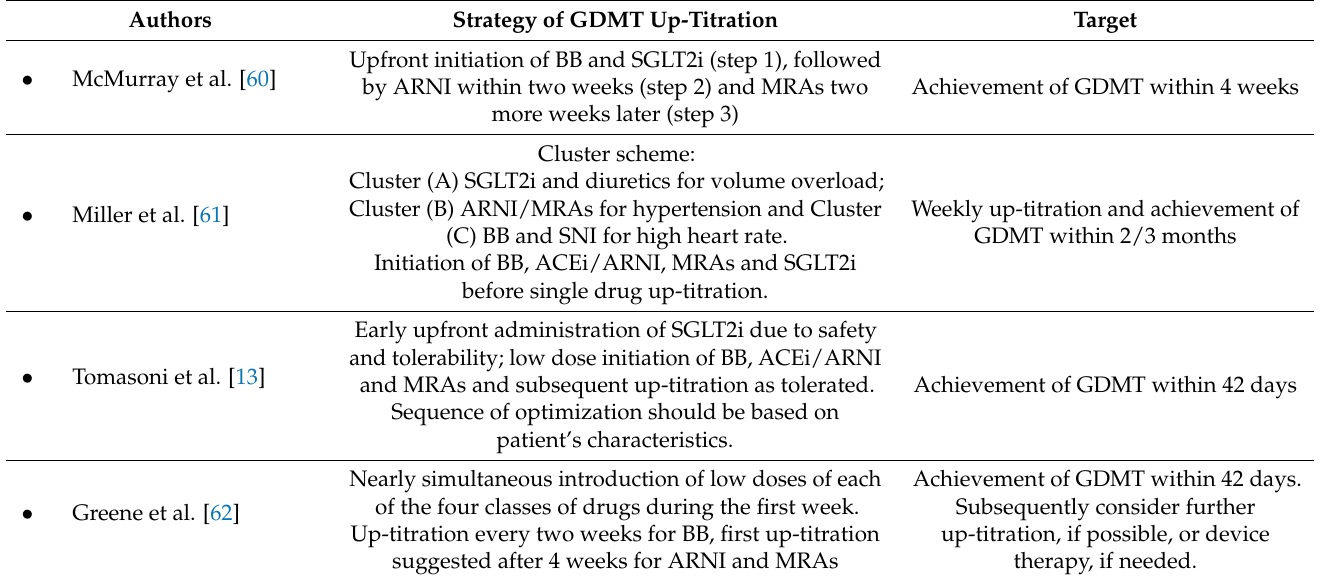
Table 3. Proposed algorithms of guidelines-directed medical therapy initiation and up-titration in patients with heart failure with reduced ejection